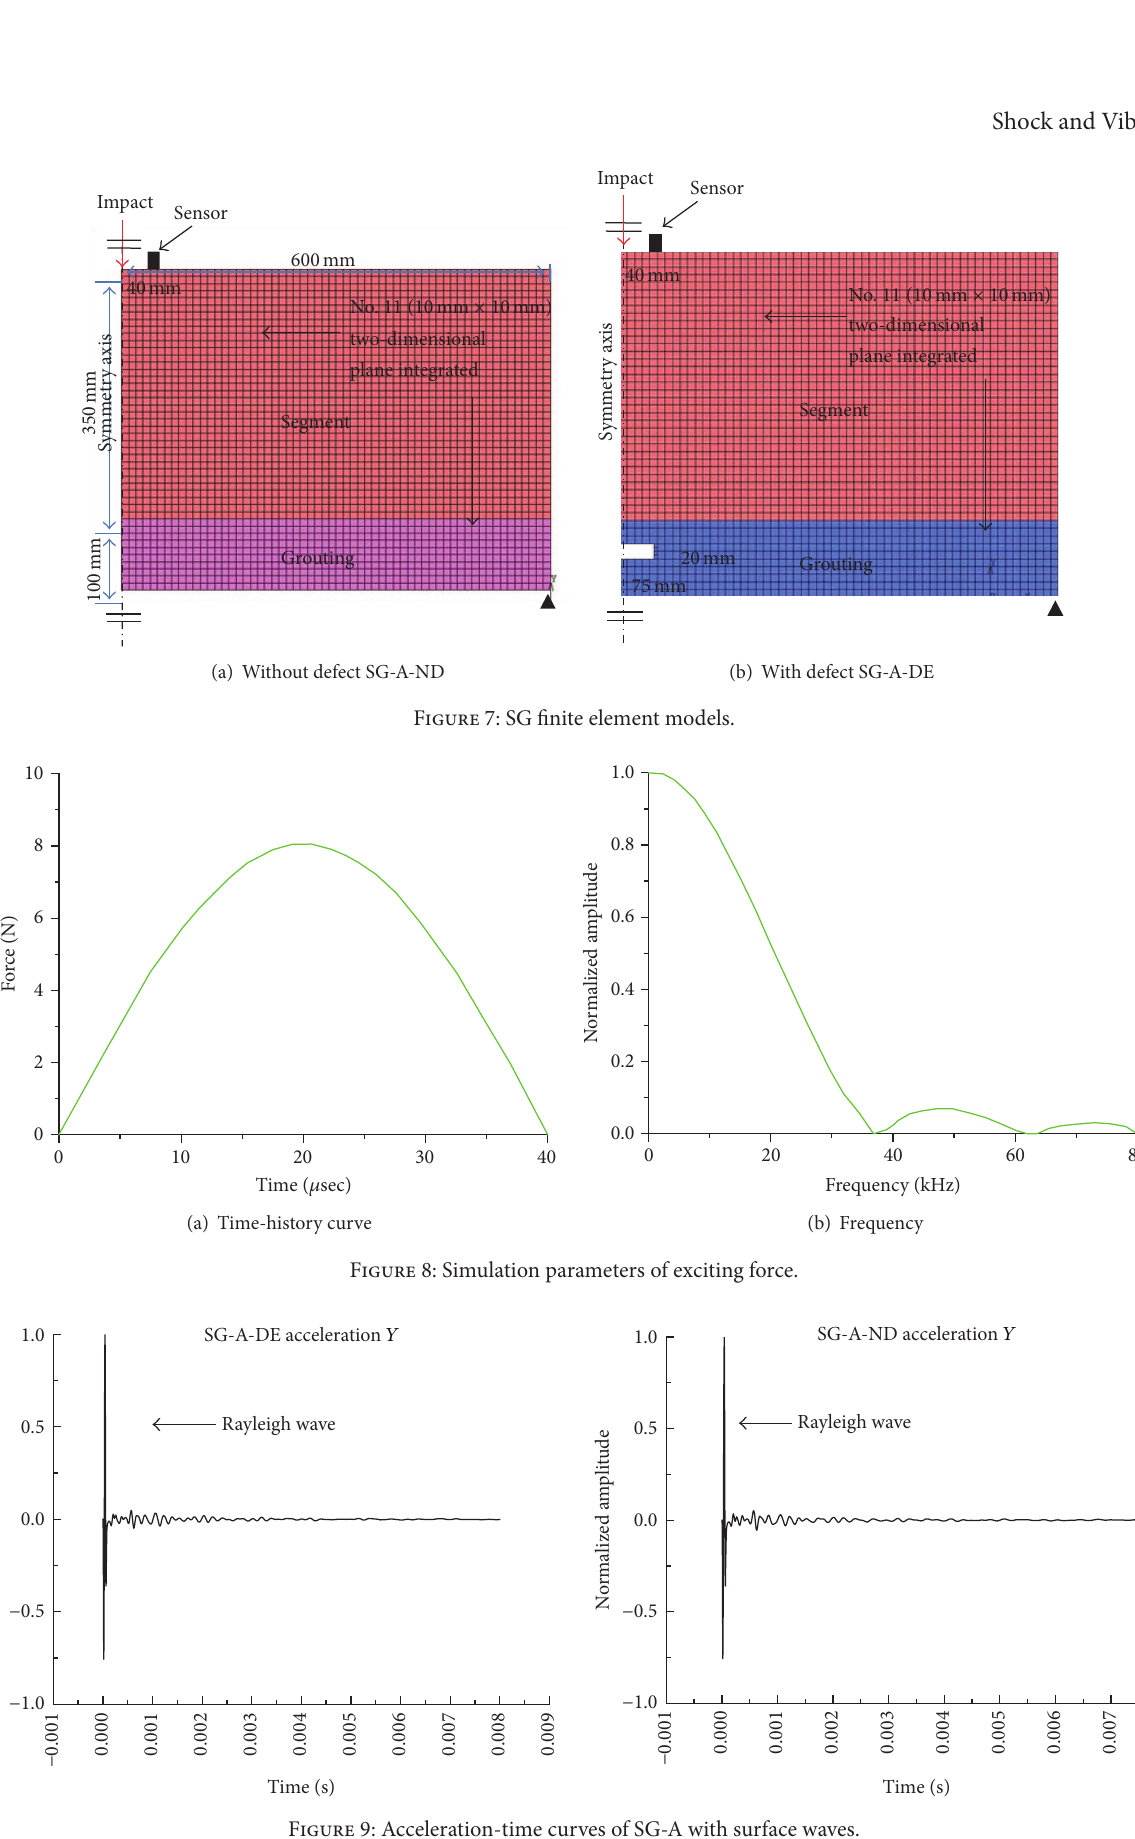
Figure 9: Acceleration-time curves of SG-A with surface